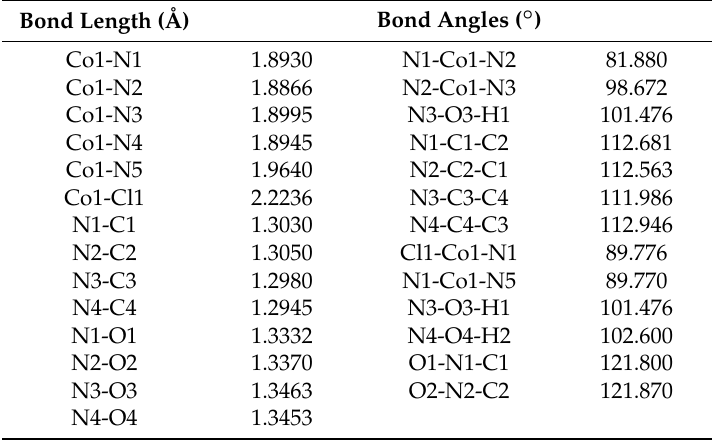
Table 2. Selected bond lengths and bond angles for [CoCl(dpgH) 2 (pytpy)].